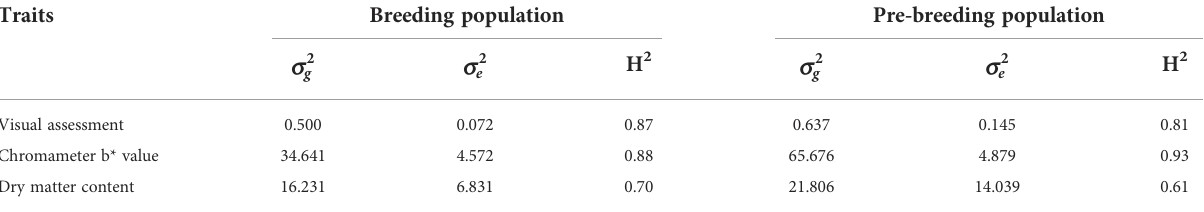
TABLE 2 Broad-sense heritability calculated on a mean plot basis for root visual assessment, chromameter value, and dry matter content in the two cassava populations. Traits Breeding